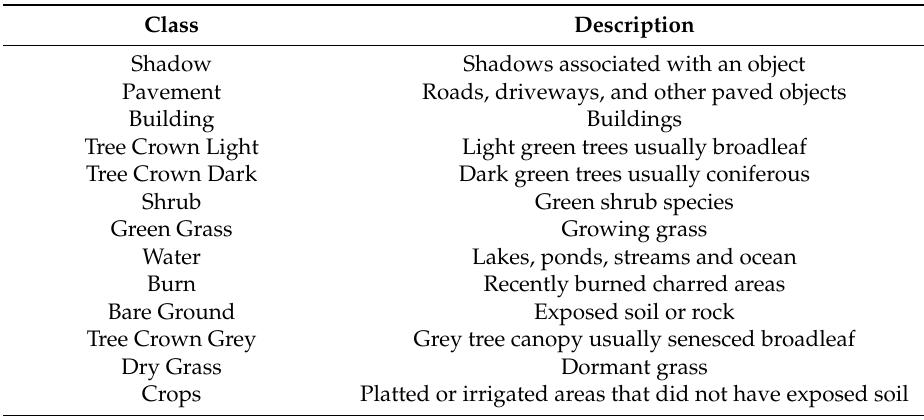
Table 1. Land cover classes and